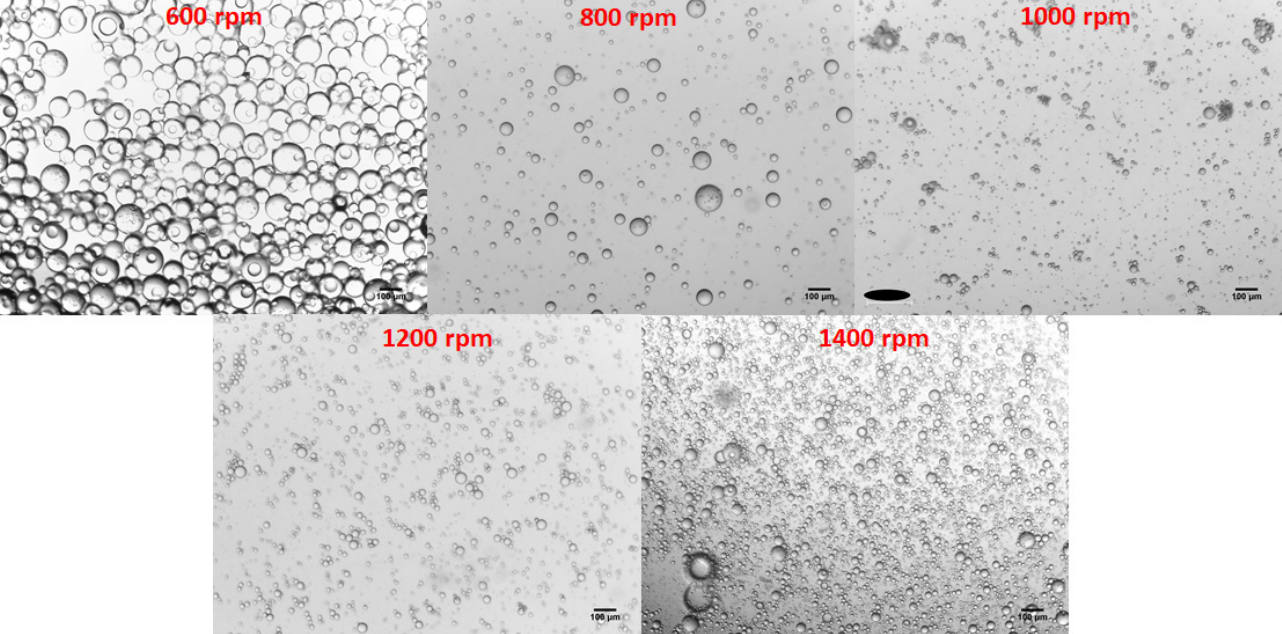
Figure 5. How the stirring speed effects the particle size generated during the emulsion polymerization process with ( a ) relating the average achieved particle sizes with the rpm used (error bars being the ± 1 standard deviation in the size measurements), and ( b ) the distribution of the particle sizes at each speed.